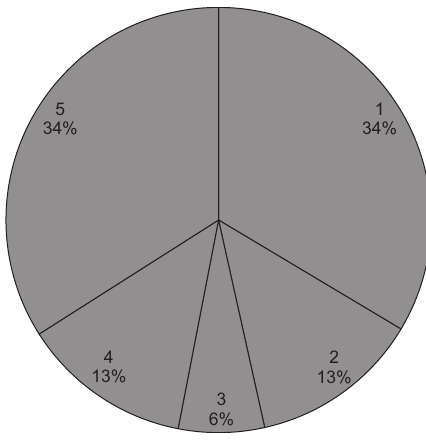
Fig. 6. The structure of total accommodation capacity in the Danube Gorge (2019).